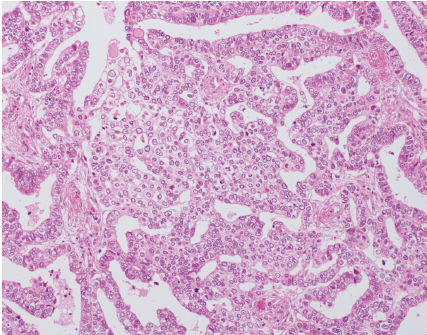
Figure 5: Microscopic findings of an excised specimen of the tumor. A clear cytoplasm and round-shaped dense nuclei with severe atypia, suggesting cell adenocarcinoma (hematoxylin and eosin stain